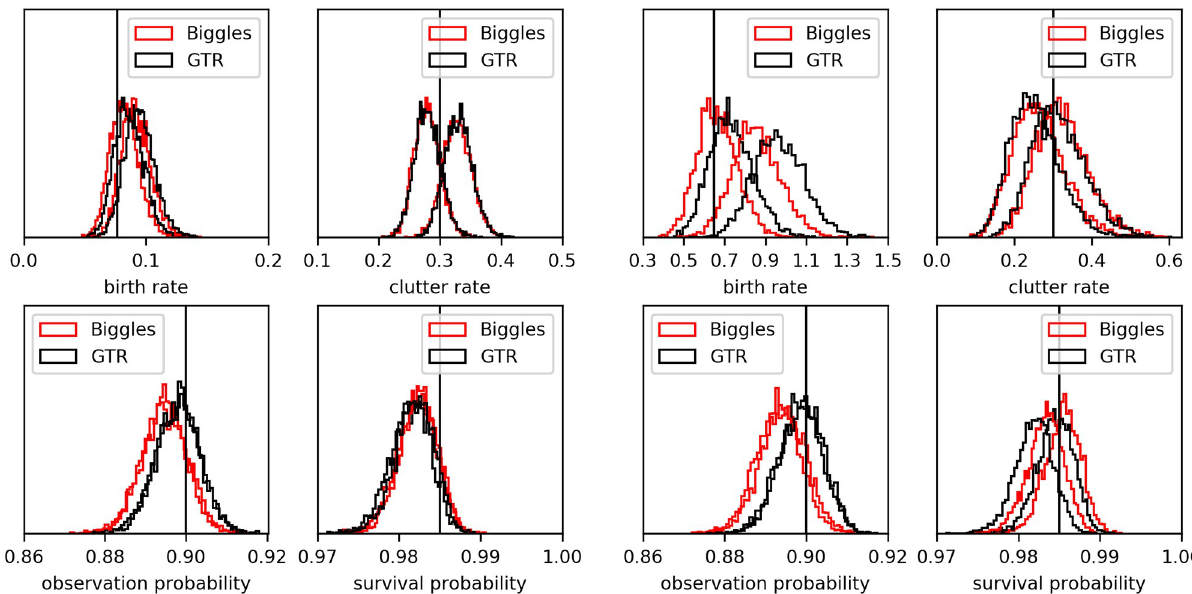
Fig 4. Recovery of the simulation parameters. The histograms of the parameter samples for the GTR (black) and the parameter samples created by Biggles (red). A pair of data sets is shown with low track density (left) and a pair with high track density. The ground truth parameters for each pair are indicated by black vertical lines. See supplementary information for Q-Q plots for series of 10 such data